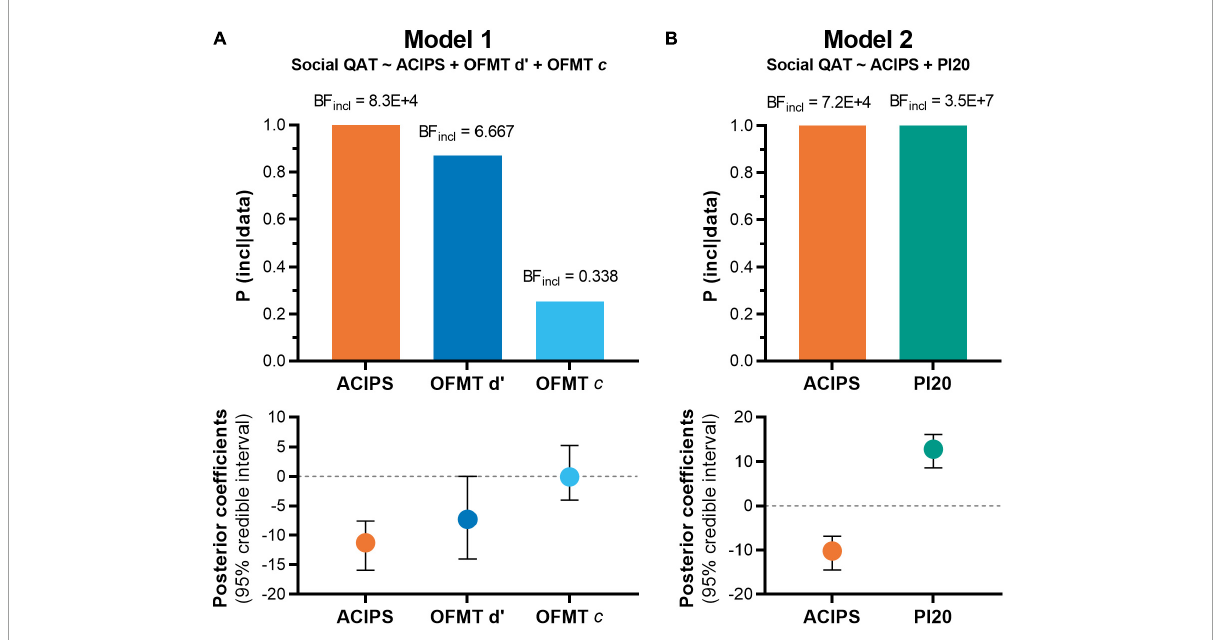
FIGURE4 Inclusion probabilities and posterior coefficients for Bayesian linear regressions. (A) Shows the first analysis, containing the ACIPS together with face matching sensitivity (d (cid:48) ) and bias (c). The upper panel shows inclusion probabilities. The lower panel shows posterior coefficients, illustrating the large effect sizes of social anhedonia (low ACIPS score) and a smaller contribution by d (cid:48) . (B) Shows the second analysis, which included self-reported prosopagnosia (PI20) instead of objective face matching measures. ACIPS, Anticipatory and Consummatory Interpersonal Pleasure Scale; BF, Bayes Factor; OFMT, Oxford Face Matching Task; PI20, 20-item Prosopagnosia